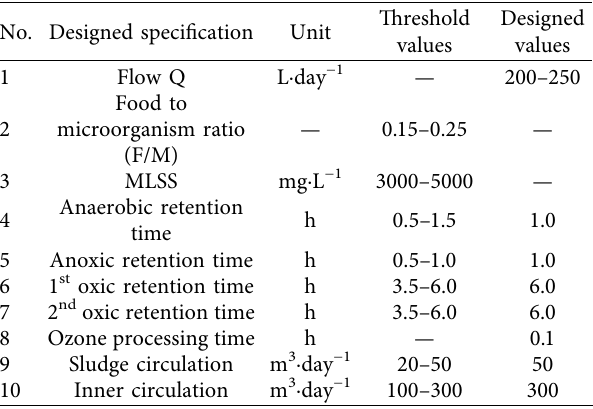
Table 2: Designed specification of the AAO/O